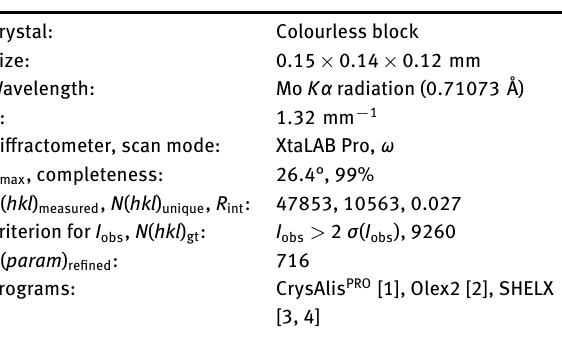
Table 1: Data collection and handling.